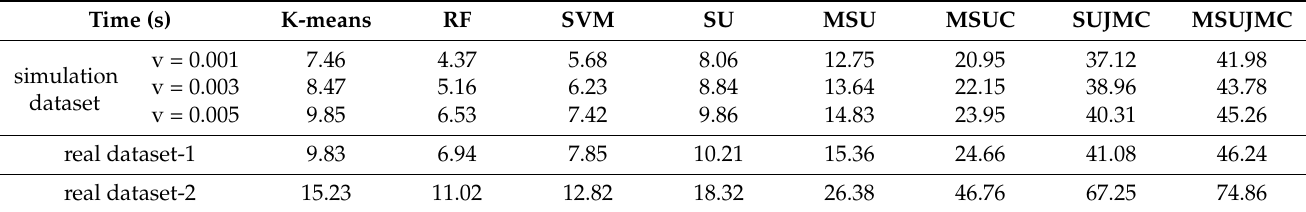
Table 5. Computational cost of the three